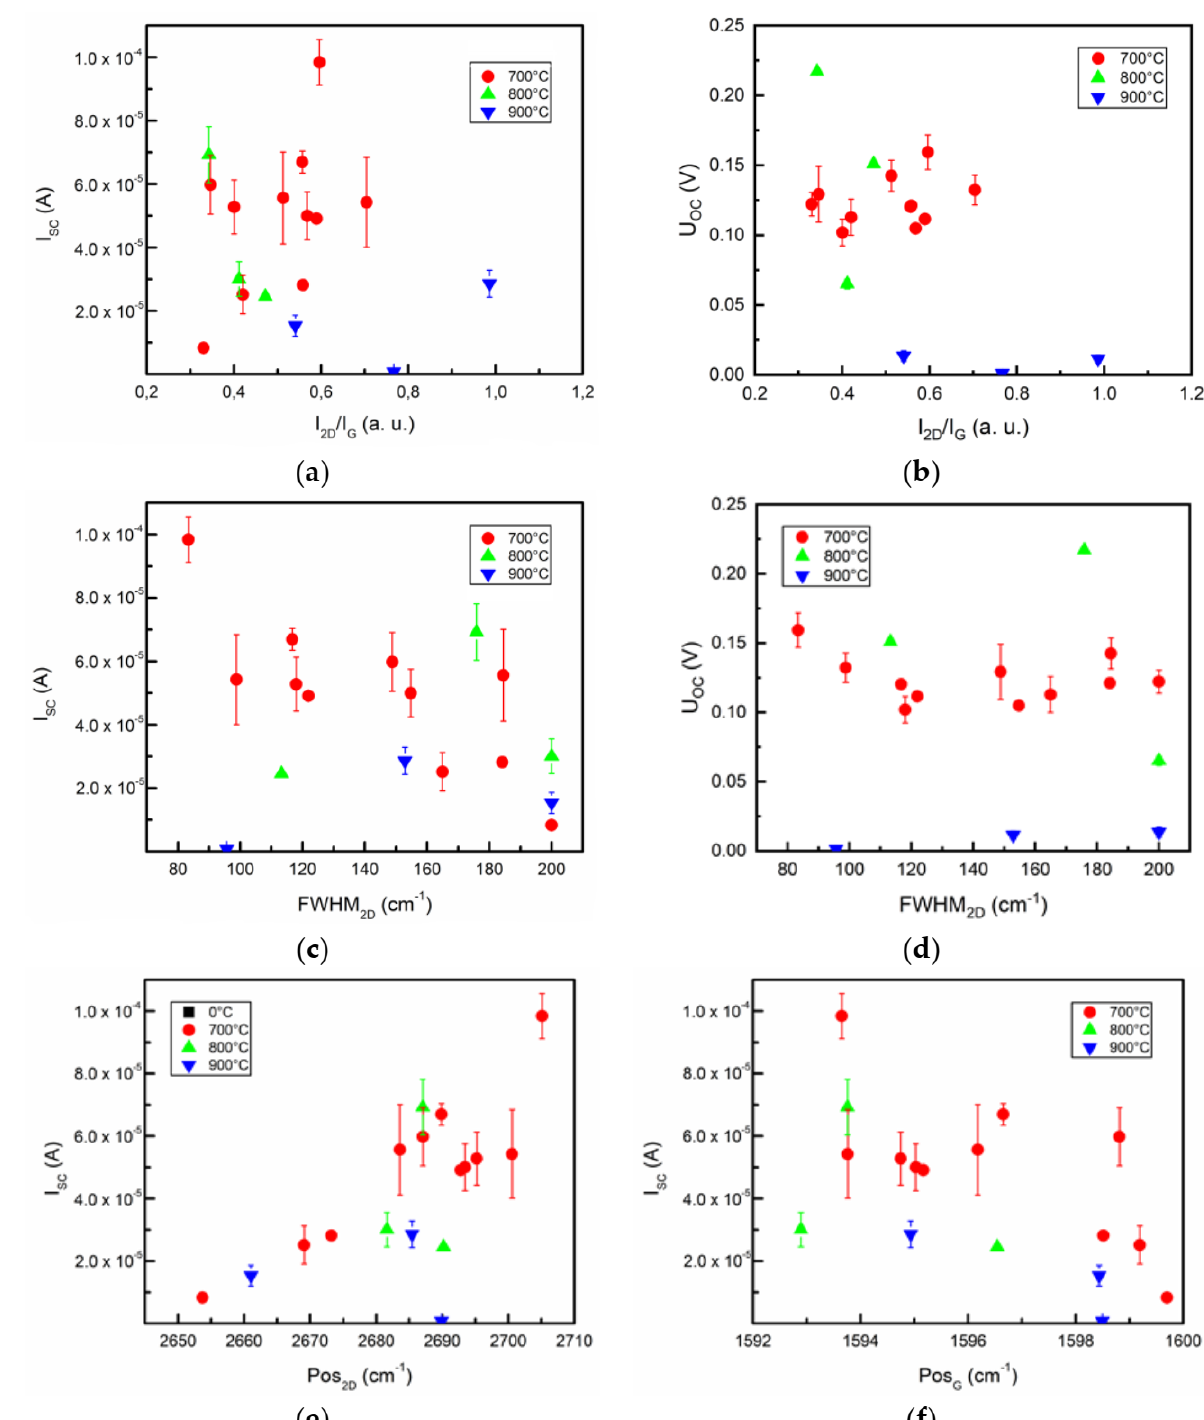
Figure 6. Structural effects on graphene/Si(100) diode’s photovoltaic parameters at 800 nm illumi- nation: ( a ) I SC vs. I 2D /I G plot; ( b ) U OC and I 2D /I G relation; ( c ) I SC relation with FWHM 2D ; ( d ) U OC vs. FWHM 2D plot; ( e ) I SC with respect to Raman 2D peak position; and ( f ) I SC and Pos G correlation. Samples were grouped according to the temperature of Si(100) substrate hydrogen plasma annealing before graphene growth: 700 ◦ C (red), 800 ◦ C (green), 900 ◦ C